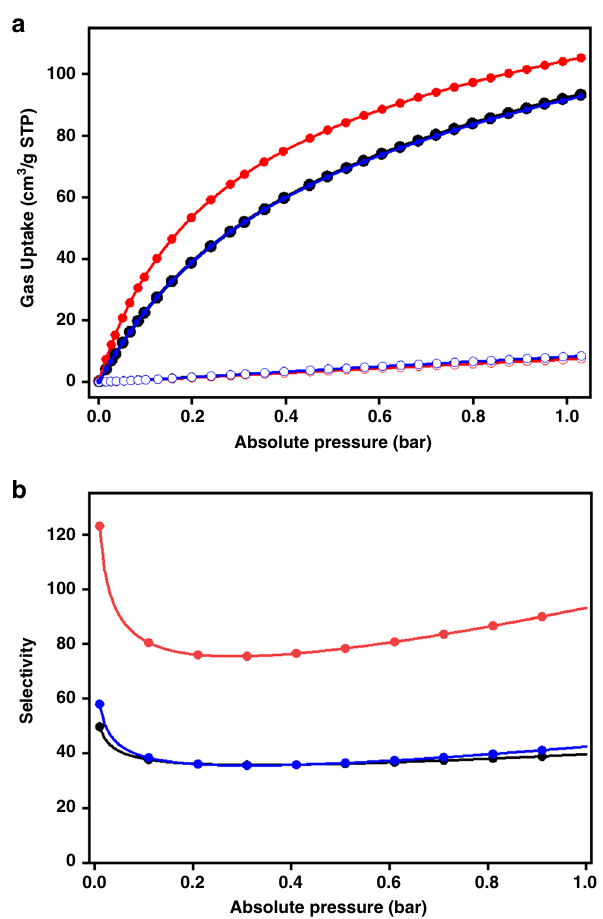
Fig. 5 Redox-triggered gas separation. a CO 2 and N 2 isotherms at 273 K: full symbols are for CO 2 , empty symbols are for N 2 ; b IAST selectivity of CO 2 /N 2 at the ratio of 15/85. Note: 3D-TPB-COF-HQ (black), 3D-TPB- COF-Q (red), 3D-TPB-COF-HQ(R)